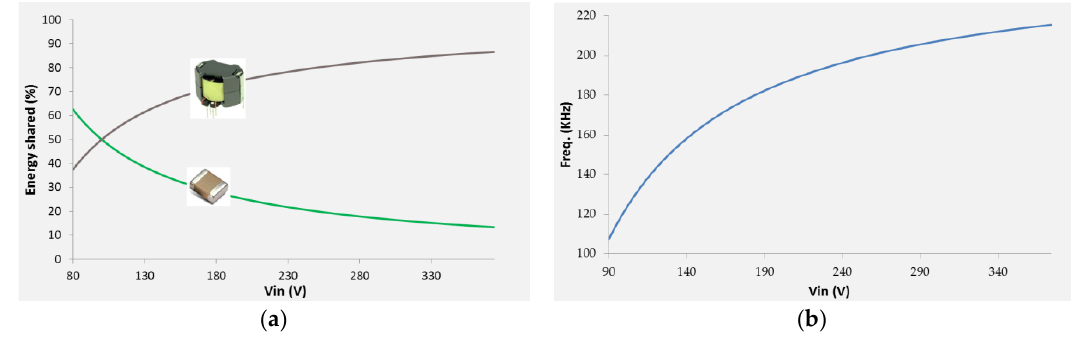
Figure 5. ( a ) Percentage of energy stored during the charge phase of the converter over Vin , Vcr = 50 V; ( b ) switching frequency of the resonant converter over Vin using the proposed control method.